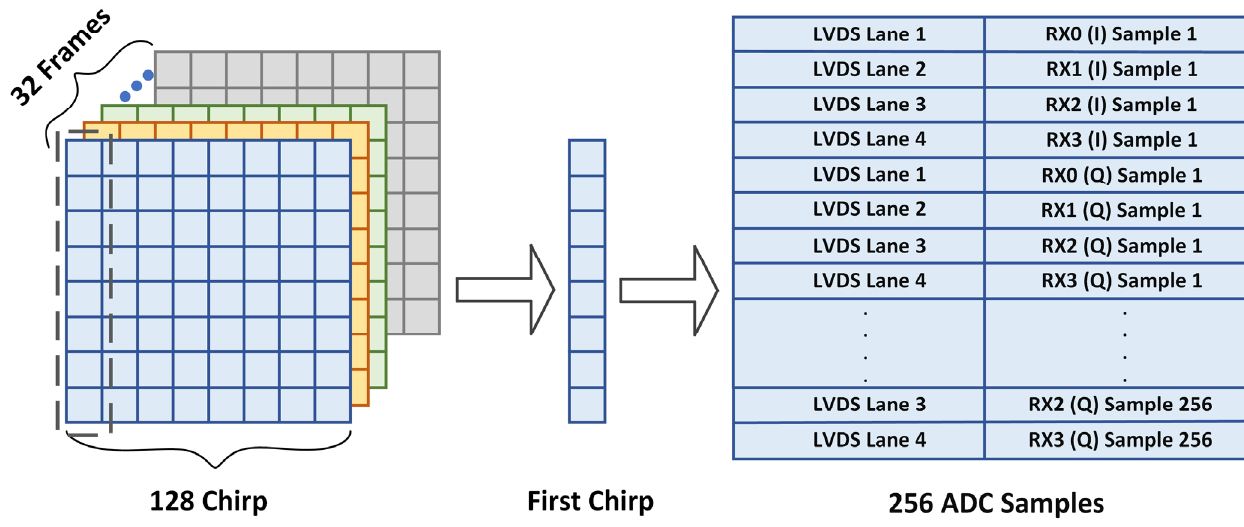
Figure 9. Details of data arrangement.